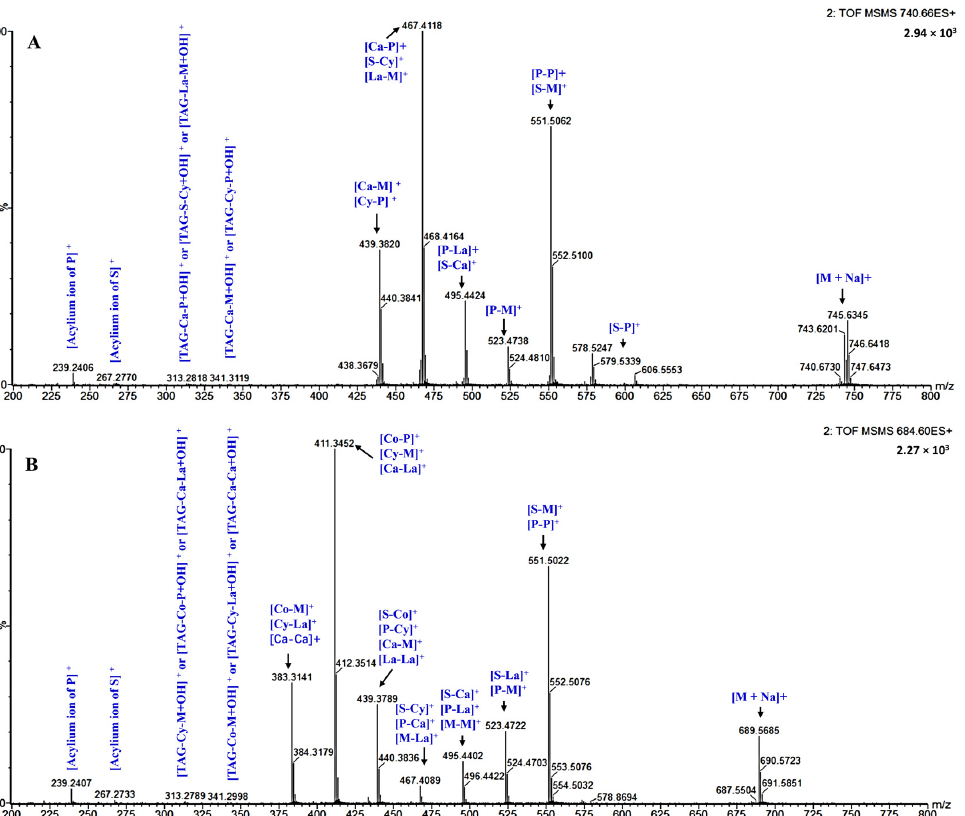
Figure 2. MS 2 spectra and fragmentations of [M + NH 4 ] + for the most abundant TAGs identified in ( A ) Guanzhong goat milk fat, ( B ) Xinong Saanen goat milk fat at m/z 740.6712 and 684.6094, respectively, under the positive ion (ESI + ) mode. Co, caproic acid (C6:0); Cy, caprylic acid (C8:0); Ca, capric acid (C10:0); La, lauric acid (C12:0); M, myristic acid (C14:0); P, palmitic acid (C16:0); S, stearic acid (C18:0); M + Na, molecular weight + sodium.